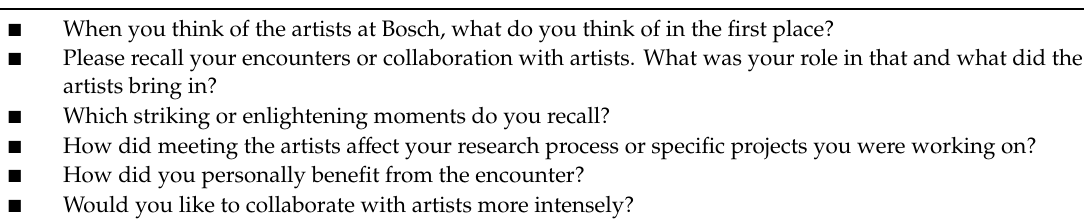
Table 1. Sample questions from the interview